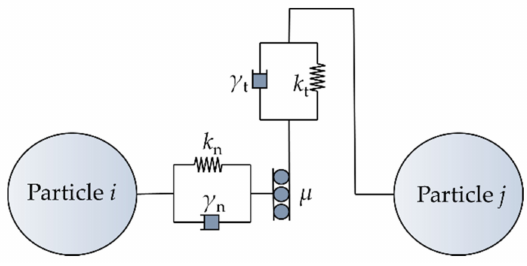
Figure 3. Hertz–Mindlin contact model.